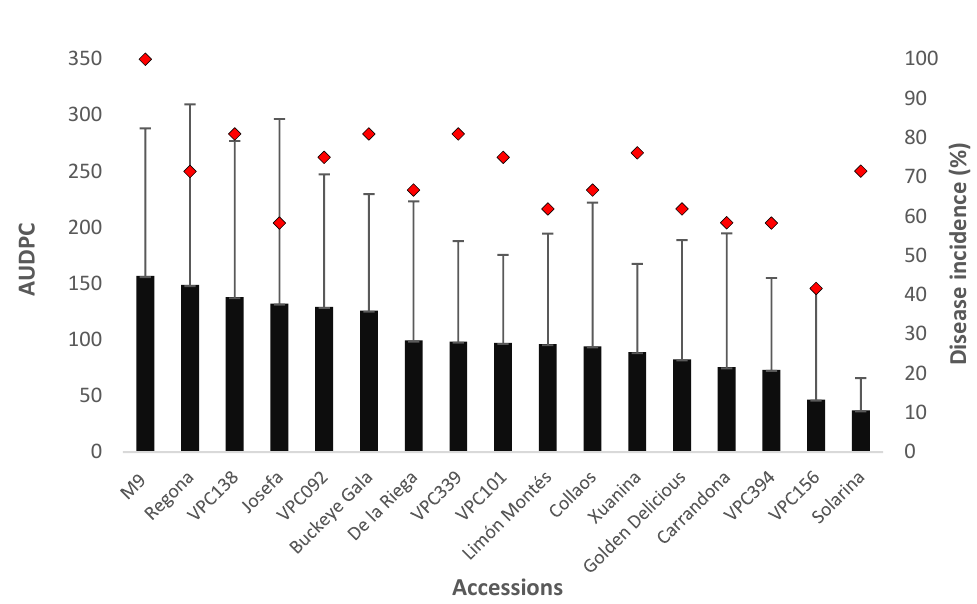
Figure 2. Mean area under disease progress curve (AUDPC; mean ± SD) and disease incidence (pro- portion of infected wounds as a percentage of the number of inoculated wounds) for 1-year-old potted trees inoculated with a single N. ditissima isolate calculated 71 days post-infection. The solid black bars represent AUDPC values whereas the red rhombuses indicate the disease incidence